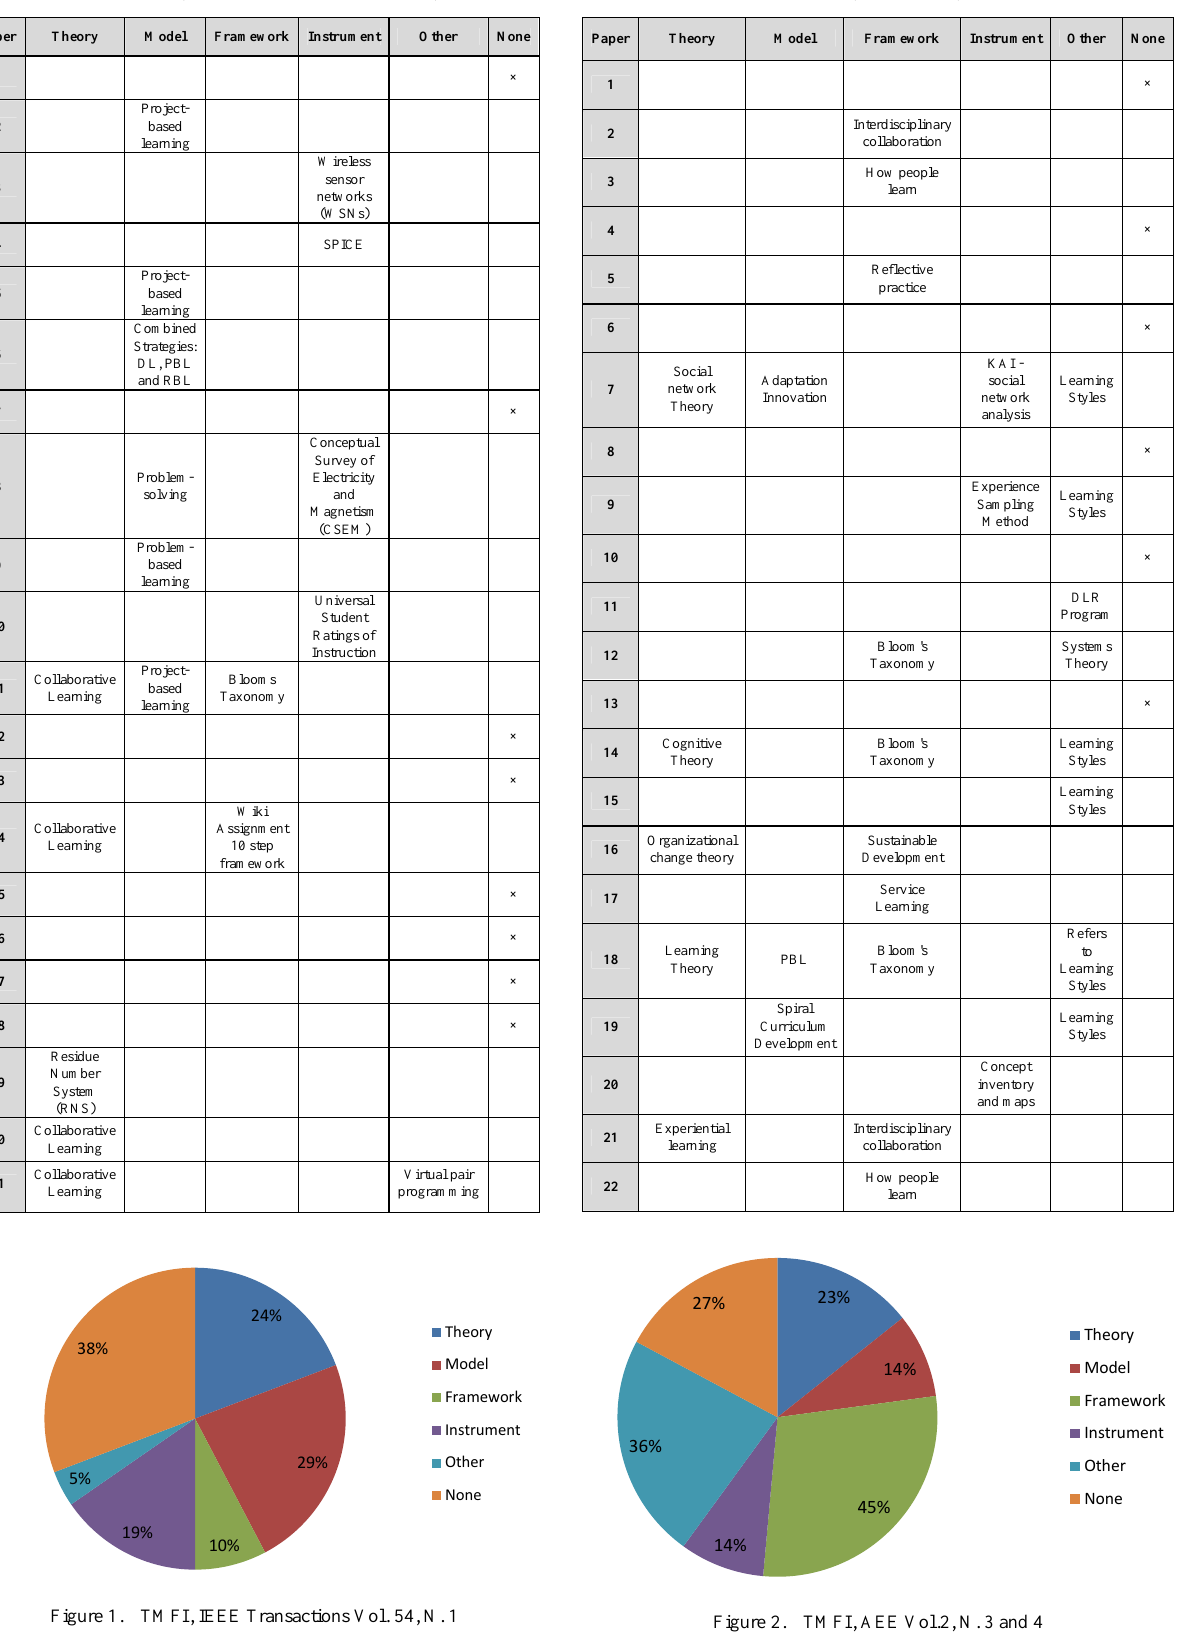
TABLE II. TMFI D IMENSION , AEE V OL .2, N. 3 AND 4